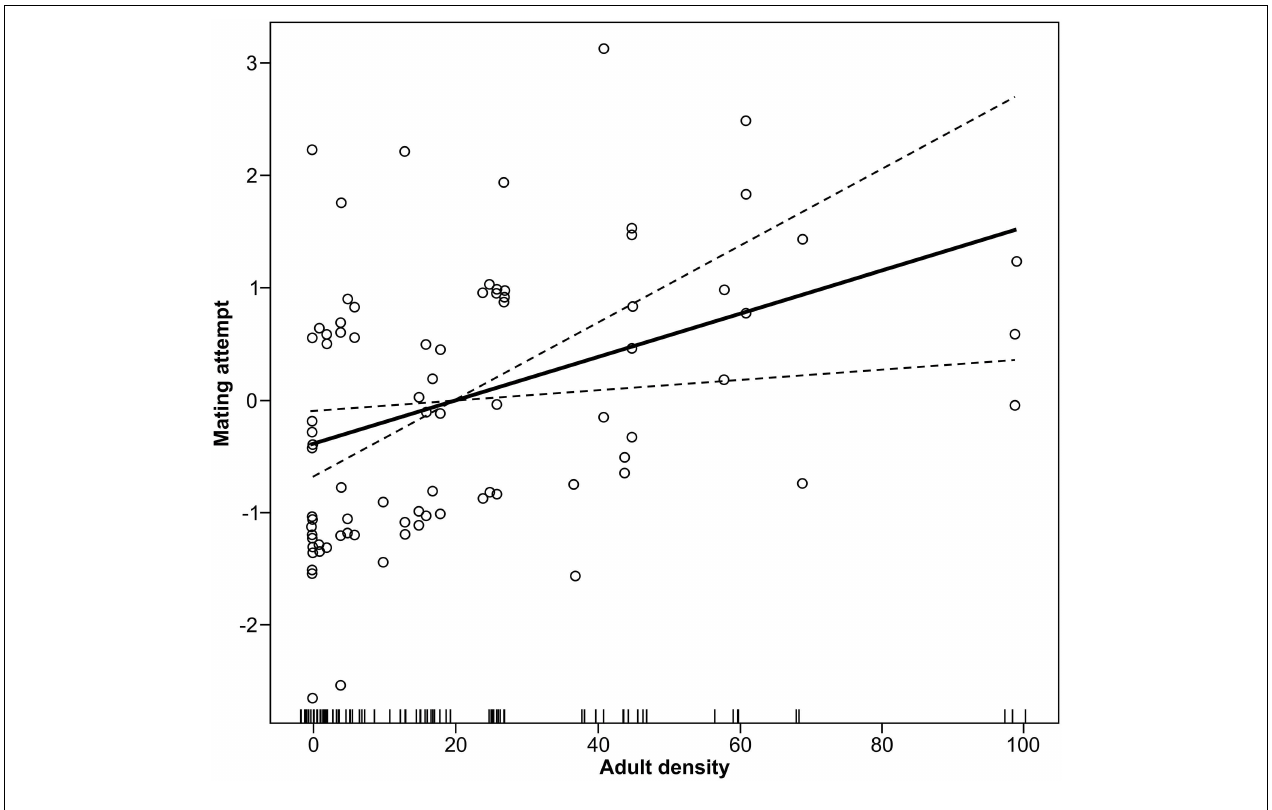
FIGURE 1 | Linear effect of moth density on mating attempts in the forest tent caterpillar. Mating attempt is measured by ability of a female to attract a male. The Y-axis is the added